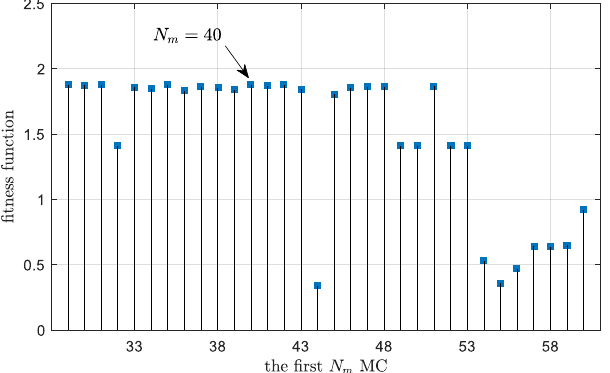
Figure 10. Fitness function of damage case B at a 3% level of noise, for the ITR method.